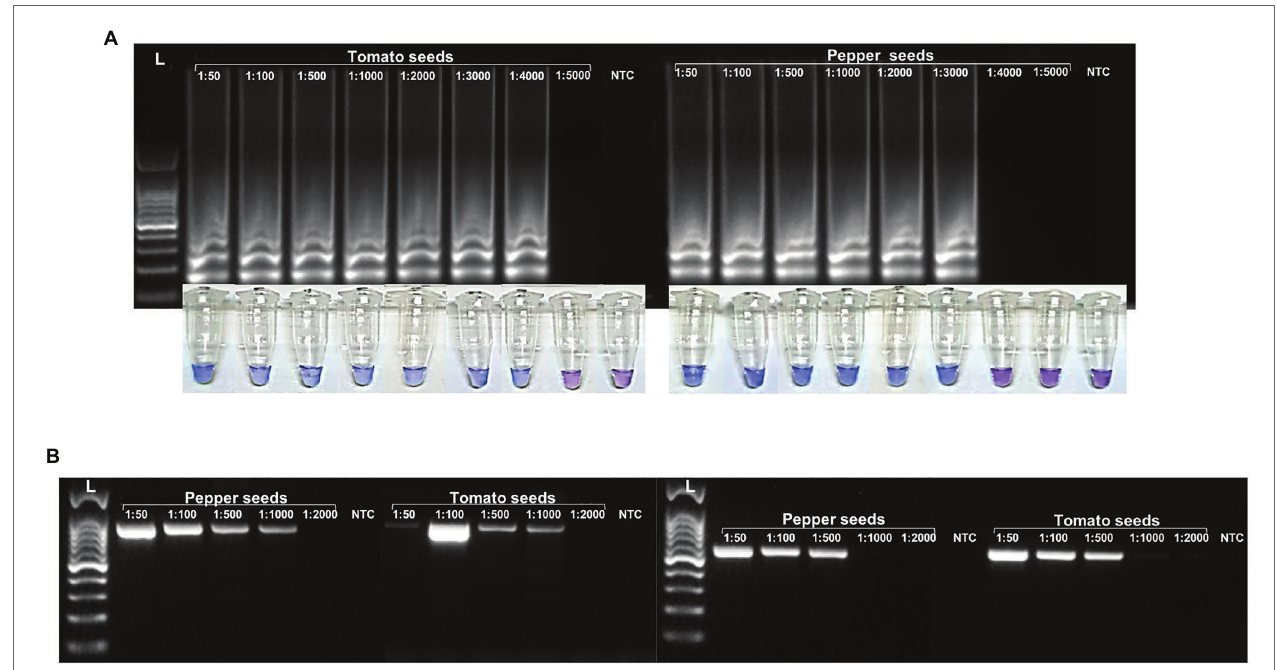
FIGURE 7 | Comparison of ToBRFV sensitivity detection between RT-LAMP (A) and RT-PCR, based on the results of Ling et al. (2019; B , left) and Alkowni et al. (2019; B , right) using 10-fold serial dilutions of purified total RNA extracted in contaminated pepper and tomato